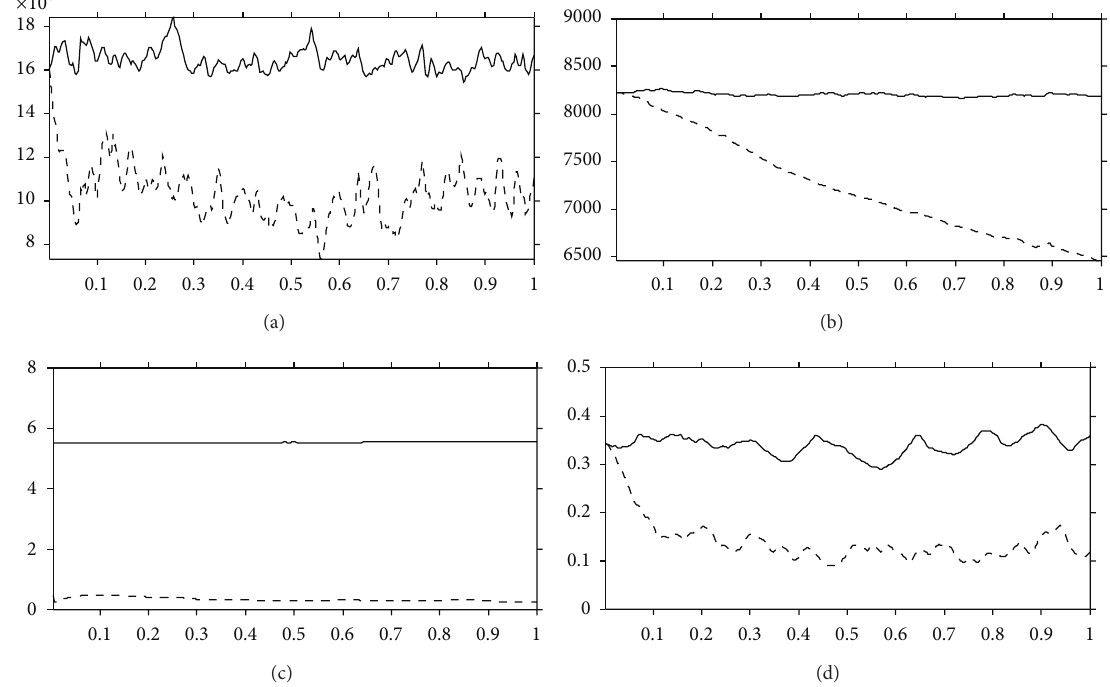
Figure 10: Time series of RMSEs of (a) atmospheric stream function, (b) oceanic stream function, (c) sea surface temperature, and (d) land surface temperature for CTRL (solid curve) and GDF (dashed curve).